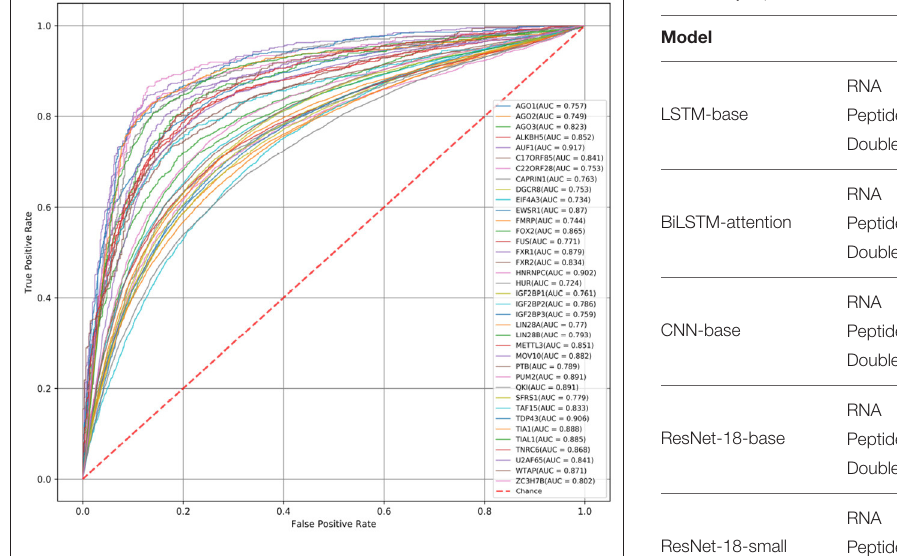
TABLE 2 | Experimental results of different models a